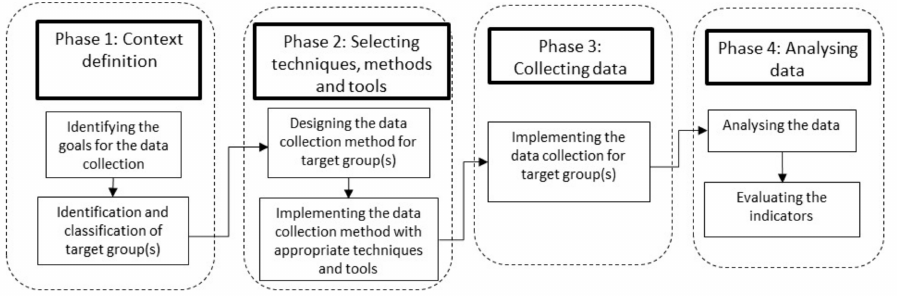
Figure 1. Phases of the